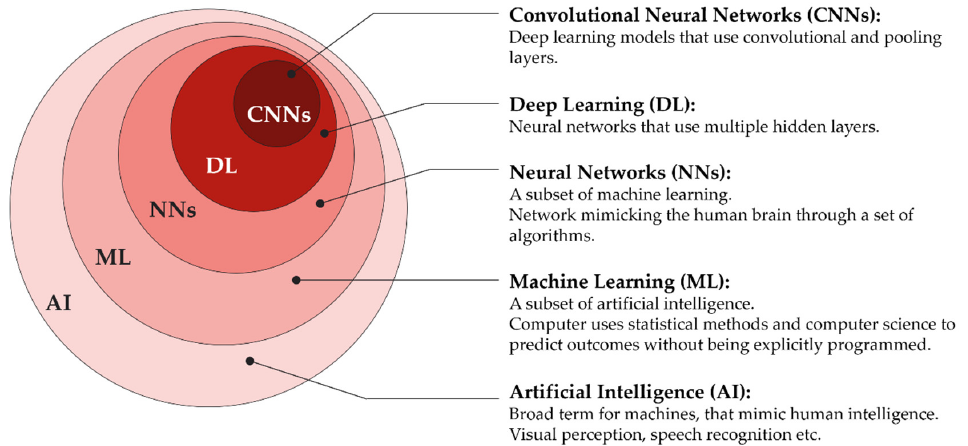
Figure 3. Set diagram describing the relationship of Artificial intelligence (AI) being the umbrella term for everything inside the outer circle, Machine learning (ML) for everything inside the second- outer circle, etc. Neural networks (NN), deep learning (DL), and convolutional neural networks (CNNs).